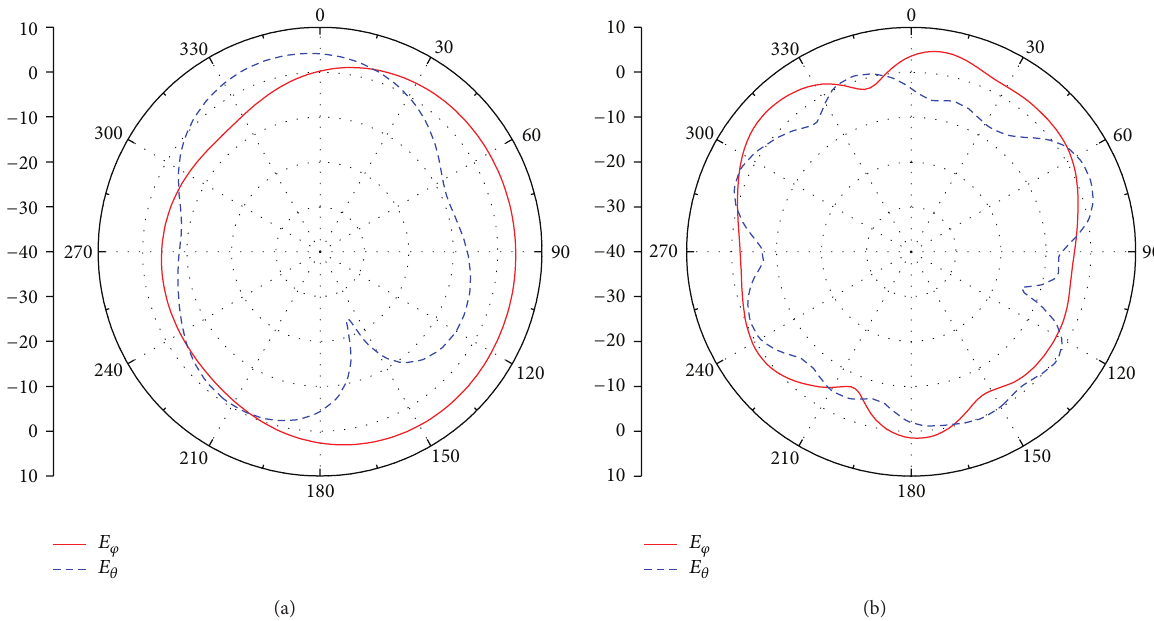
Figure 17: Simulated radiation patterns of the initial MIMO antenna in 𝑥𝑧 -plane at (a) 4GHz and (b) 9GHz.